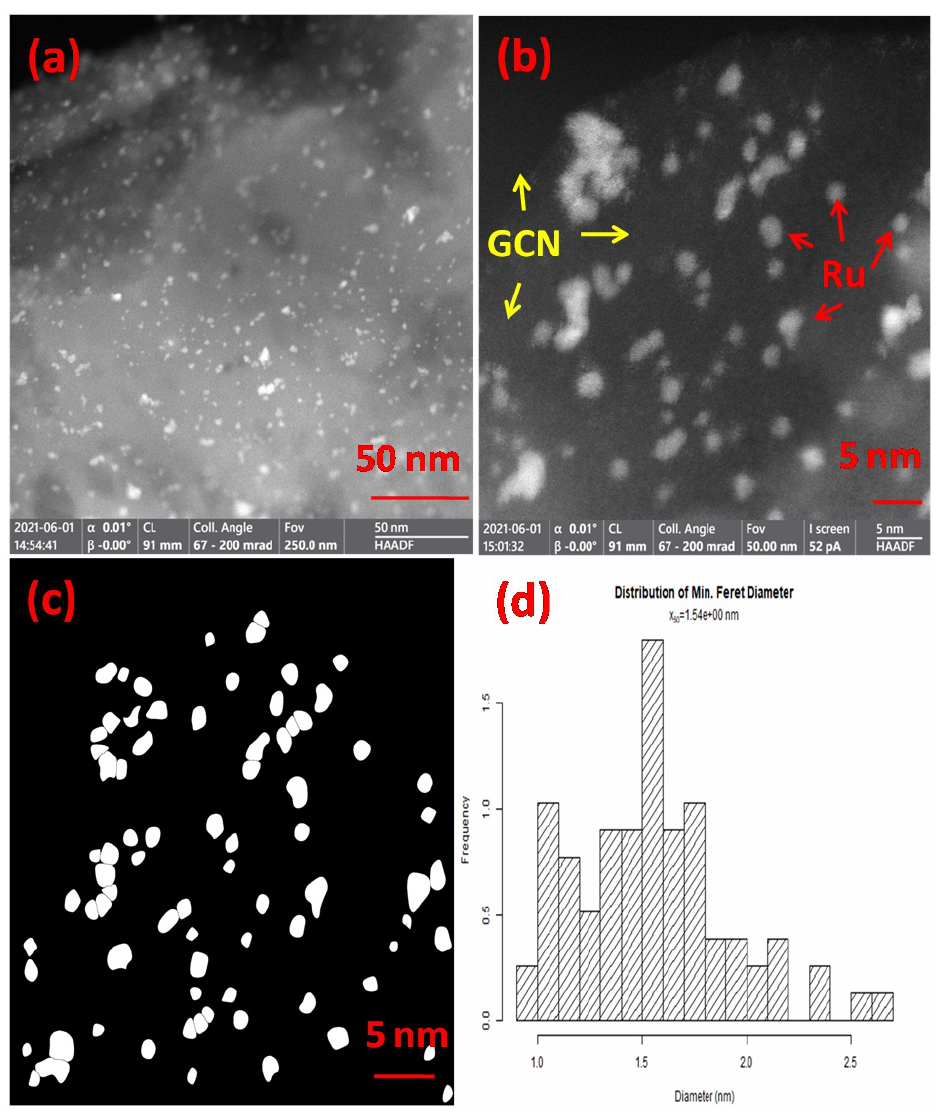
Figure 4. Scanning transmission electron microscopy (STEM) images of Ru-GCN ( a – d ) particle size distribution curve of Ru in